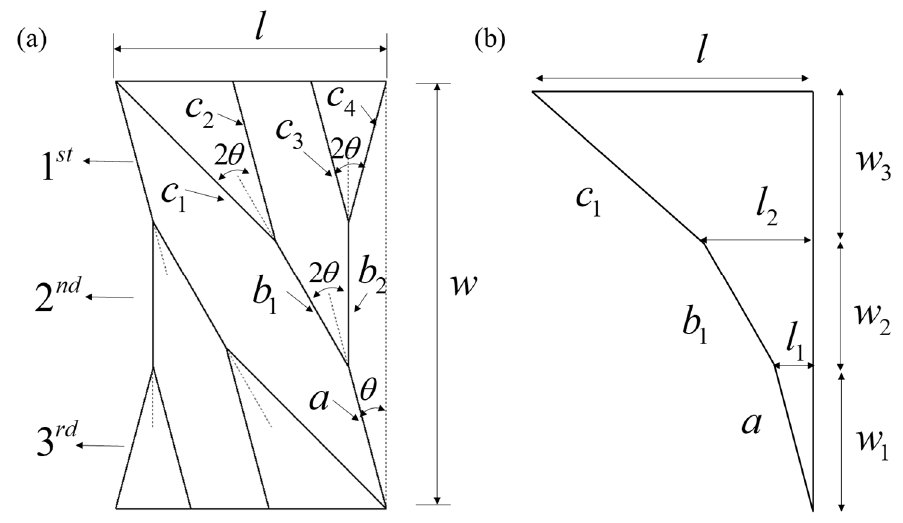
Figure 5. RVE model of bionic structure: ( a ) RVE model; ( b ) Simplified model of RVE.